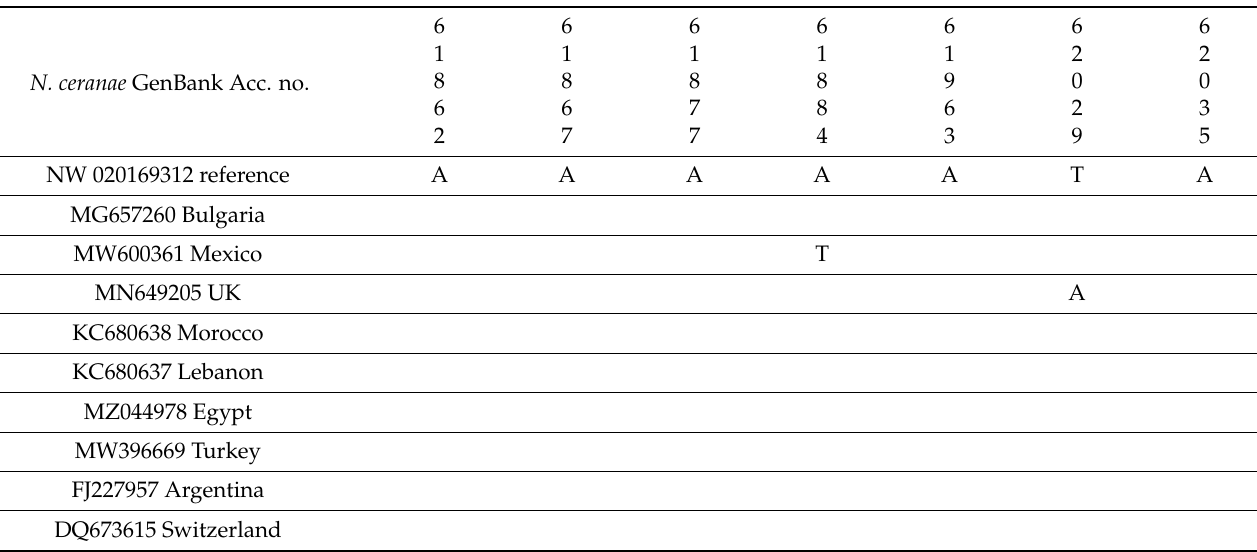
Table 2. N. ceranae sequence variation among 19 isolates from different geographical locations. A 218- bp segment of the 16r DNA from 18 different geographical sites is aligned with the reference sequence NW_020169312 part of the ASM98816v1 N. ceranae genome assembly [42]. Variable nucleotides are indicated. Sequence positions above each column are given from the start of the reference